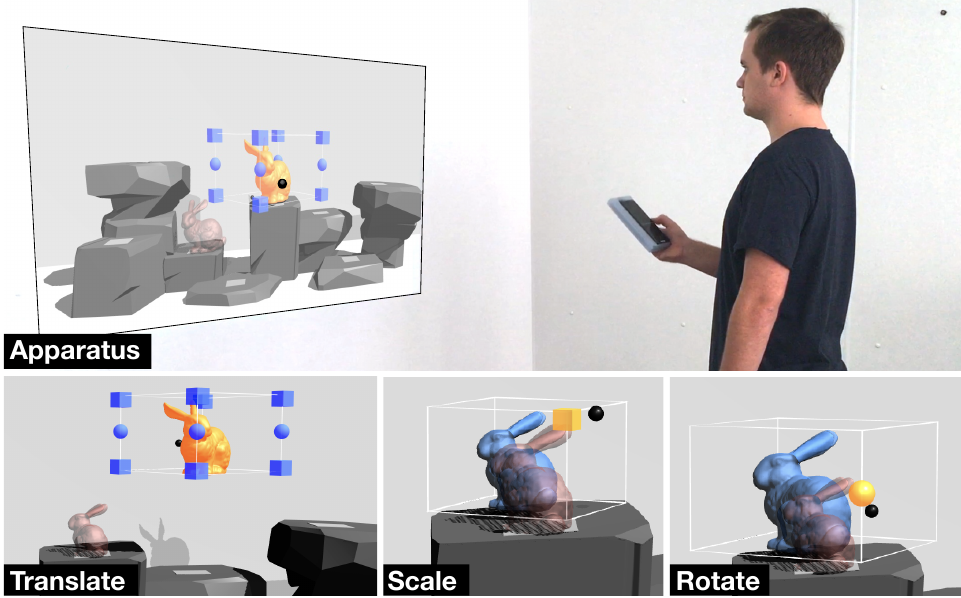
Figure 9. Real-world study apparatus for the 2D/3D study. Required interaction in the 3D study, translate, scale, and